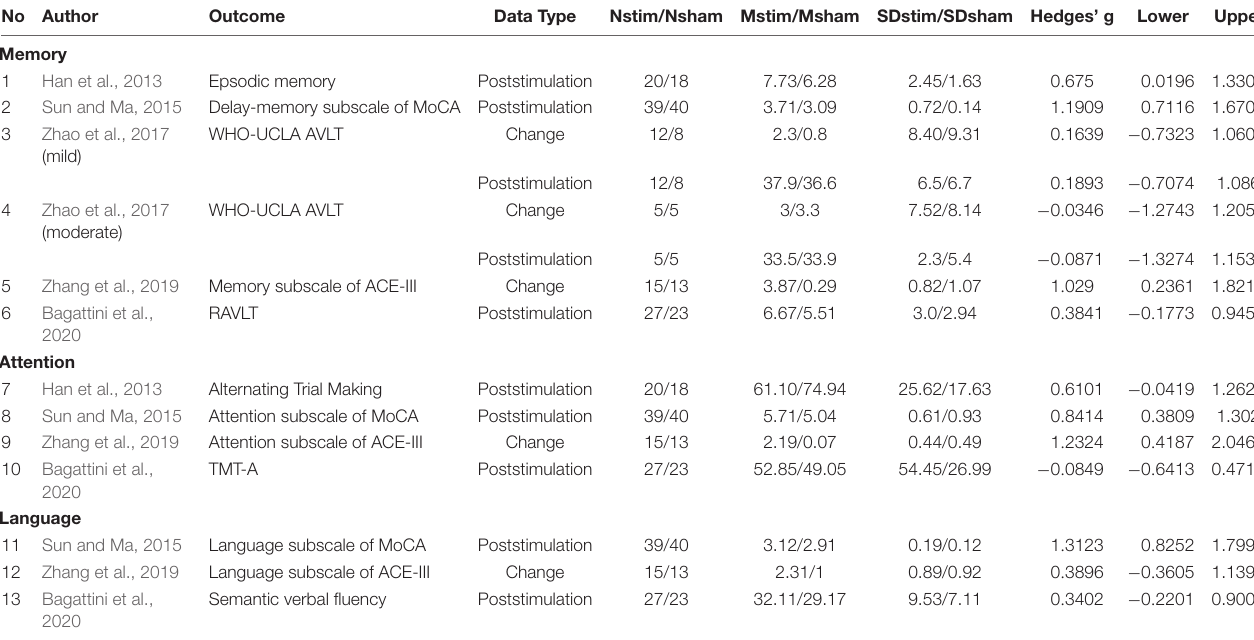
TABLE 4 | Summary of the effect sizes for different cognitive domains.